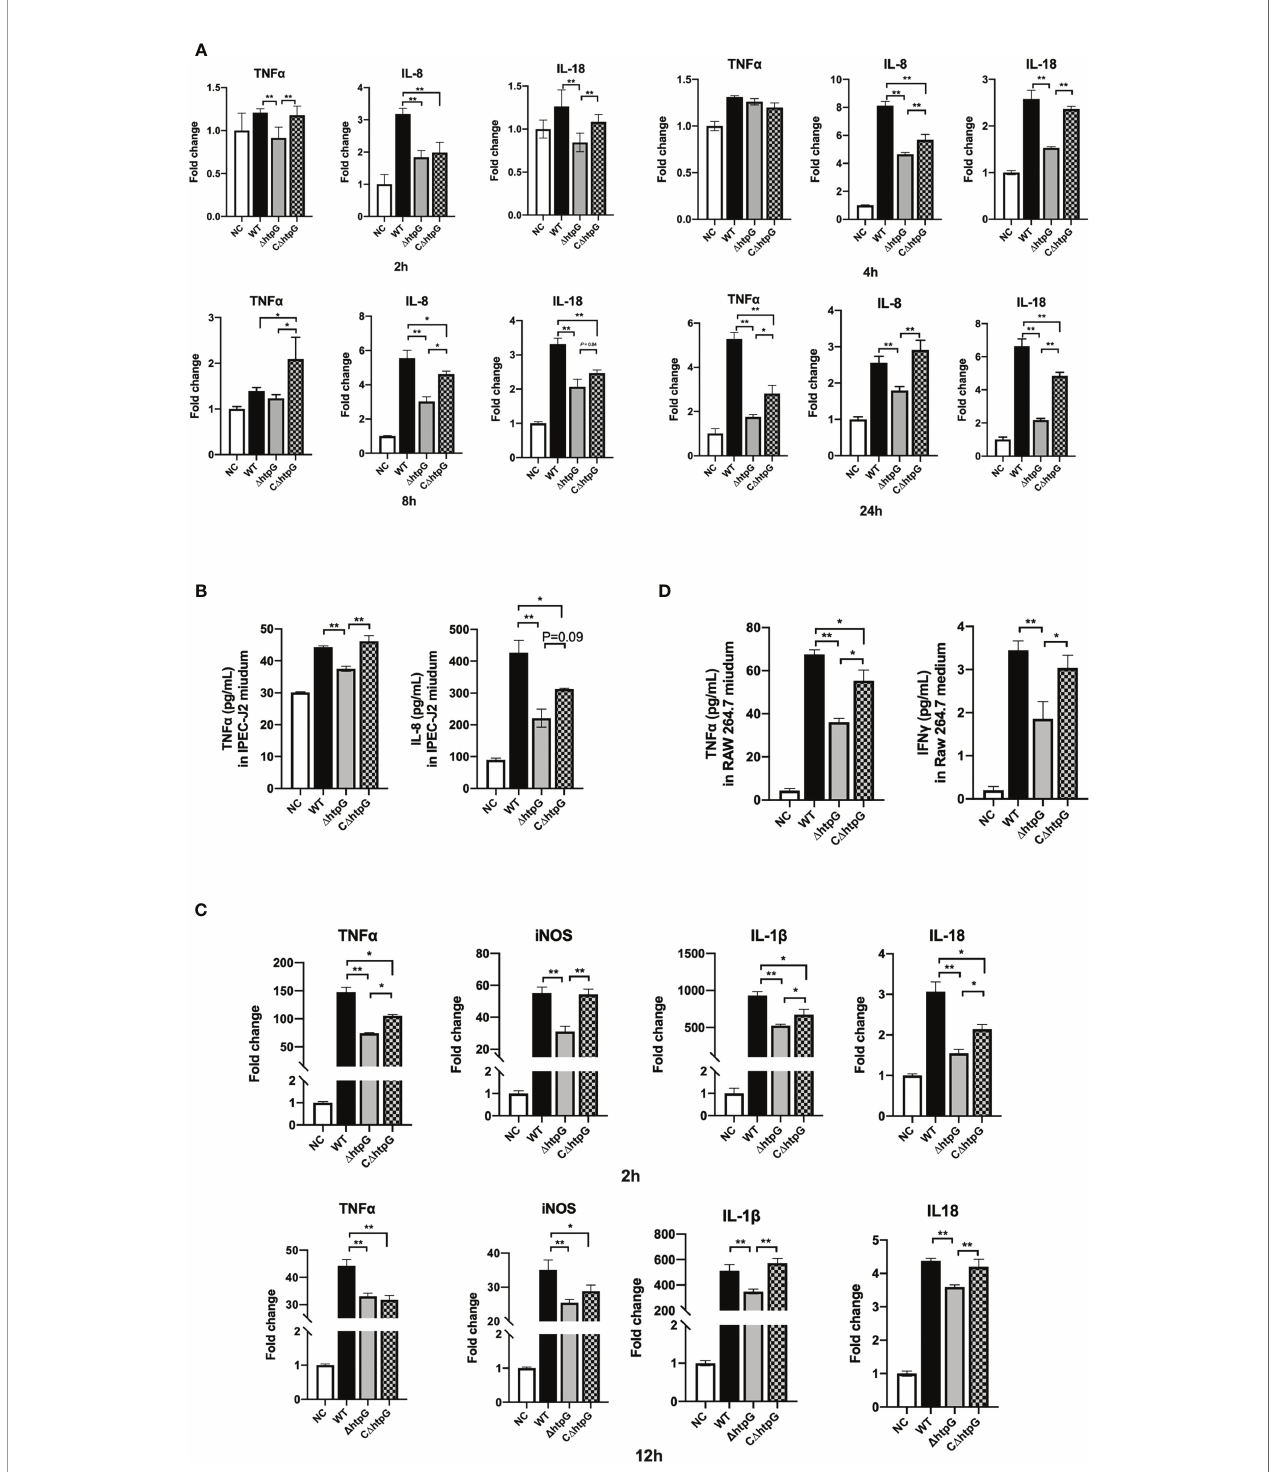
FIGURE 4 | Pro-in fl ammatory responses of host cells induced by S. Typhimurium. (A) Relative mRNA expression of in fl ammatory cytokines in IPEC-J2 cells at different infection times of S. Typhimurium. (B) The contents of in fl ammatory cytokines in the cell culture medium of IPEC-J2 cells after 12 h of S. Typhimurium infection. (C) Relative mRNA expression of in fl ammatory cytokines in RAW264.7 cells at different infection times of S. Typhimurium. (D) The content of in fl ammatory cytokines in RAW264.7 cell culture medium after S. Typhimurium infection. These results are shown as the mean ± standard error, * means p < 0.05, ** means p < 0.01, n =